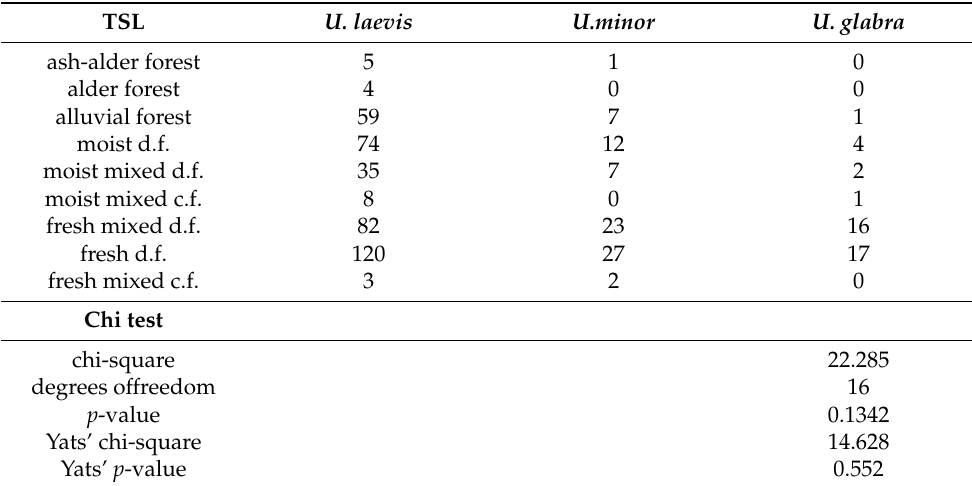
Figure 4. Percentage of individual elm localities within the specific site types distinguished in the field (topographic classification). AF—alluvial forest, ASF—alder swamp forest, FMCF—fresh mixed coniferous forest, OH-F—oak-hornbeam or similar forest, SF—slope forest, L. river—at a large river, S. river—near a small watercourse, between embank.—between flood embankments, embank.—area of flood embankments, behind embank.—behind embankments. Table 6. Number of individual elm localities in ‘forest site types’ (FST) according to forest documentation (distinguished by soil classification) and chi-square test.